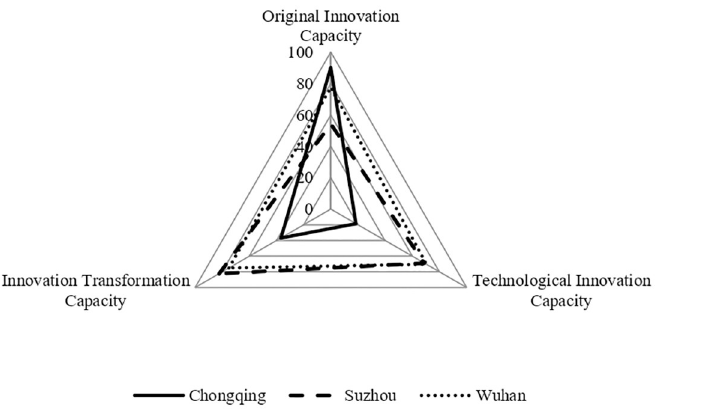
Fig 4. Three capacities of UICs in cities with low innovation